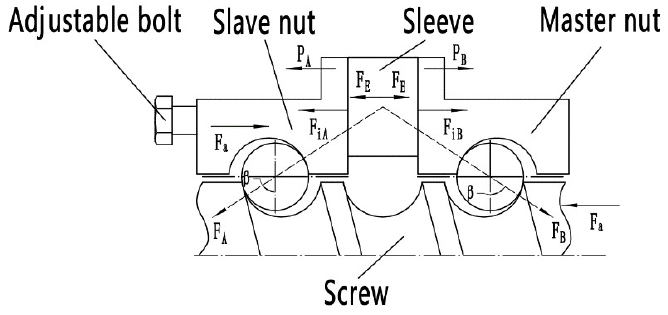
Figure 3. The force diagram of the preloaded system.